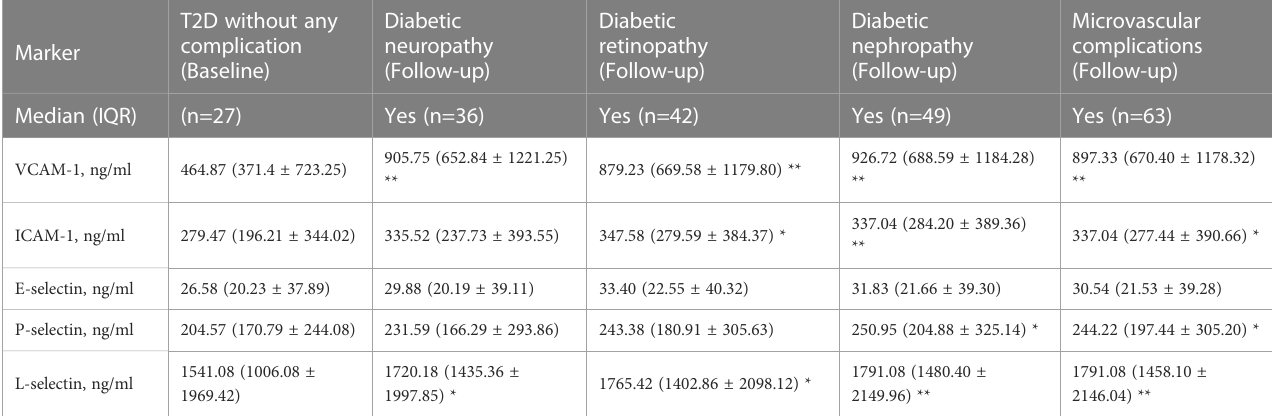
Data represents in median (interquartile range). VCAM-1 (vascular cell adhesion molecule-1), ICAM-1 (intercellular adhesion molecule-1), T2D (type 2 diabetes). Compared between T2D without any complication vs microvascular complications (Yes); T2D without any complication vs diabetic neuropathy (Yes); T2D without any complication vs diabetic retinopathy (Yes); T2D without any complication vs diabetic nephropathy (Yes). *p-value <0.05; ** p-value <0.01. p value <0.05 is statistically signi fi cant. ( # comparison of the level of markers of same patients at baseline and follow-up were shown in Supplementary Table